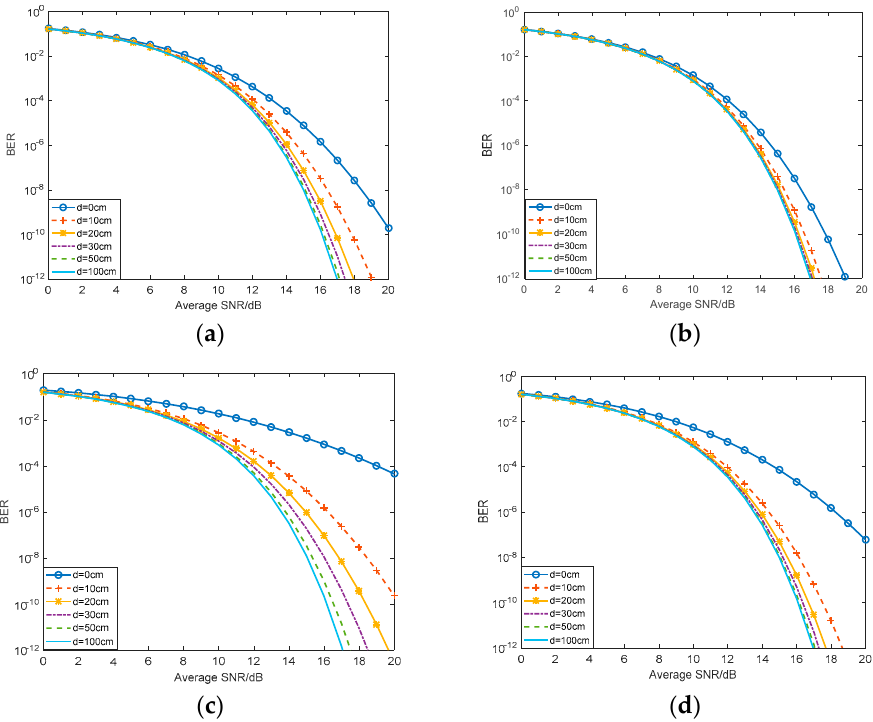
Figure 2. Performance of BER with different diameters, the turbulence conditions and zenith angles are: ( a ) A = 1.7 × 10 − 14 , w = 10, ζ = π /3; ( b ) A = 1.7 × 10 − 14 , w = 10, ζ = π /6; ( c ) A = 3.0 × 10 − 13 , w = 21, ζ = π /3; ( d ) A = 3.0 × 10 − 13 , w = 21, ζ = π /6.